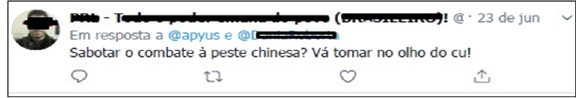
Fig. 2 A Bolsonarian co-framer talks about the Covid-19